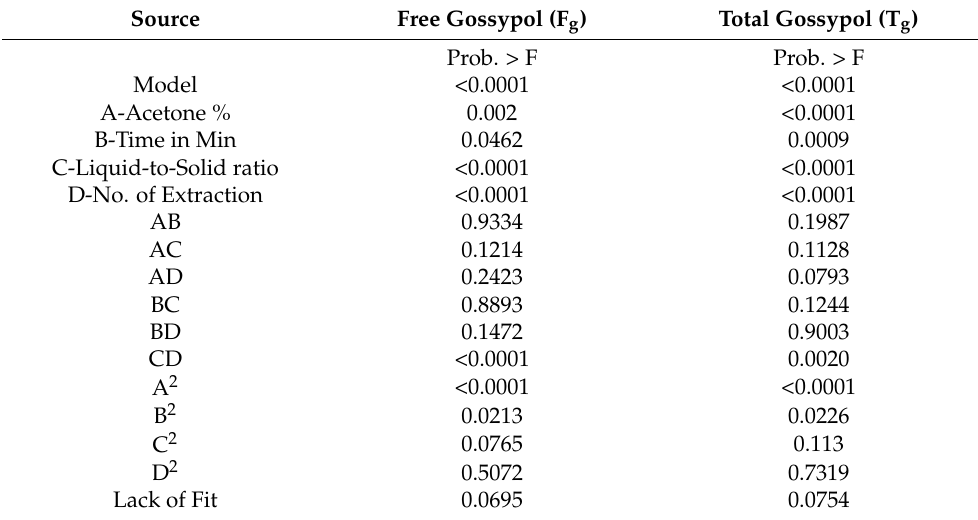
Table 5. Model summary statistics for free gossypol and total gossypol Table 4. ANOVA results for free gossypol and total gossypol reduction.